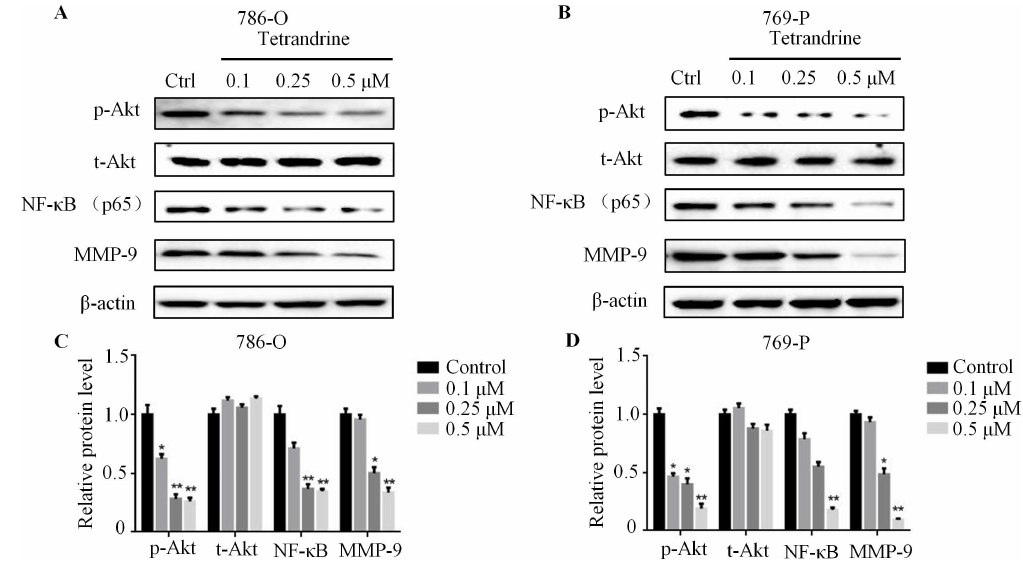
Fig 3. Tet markedlydecreasesphospho-AKT, NF- κ B and MMP-9 expression in human RCC. 786-O ( A ) and 769-P ( B ) cells treated with vehicleor Tet (0.1 μ Mto 0.5 μ M) for 24 h were immunoblotted for the expressionof AKT, phospho-AKT, NF- κ B and MMP-9. β -actinwas used as a loadingcontrol. The quantitative data were shown in the lower panel ( C,D ). The values were showedas mean ± S.E.Representative results from three independent experiments were shown ( ** means P < 0.05, *** means P < 0.01).